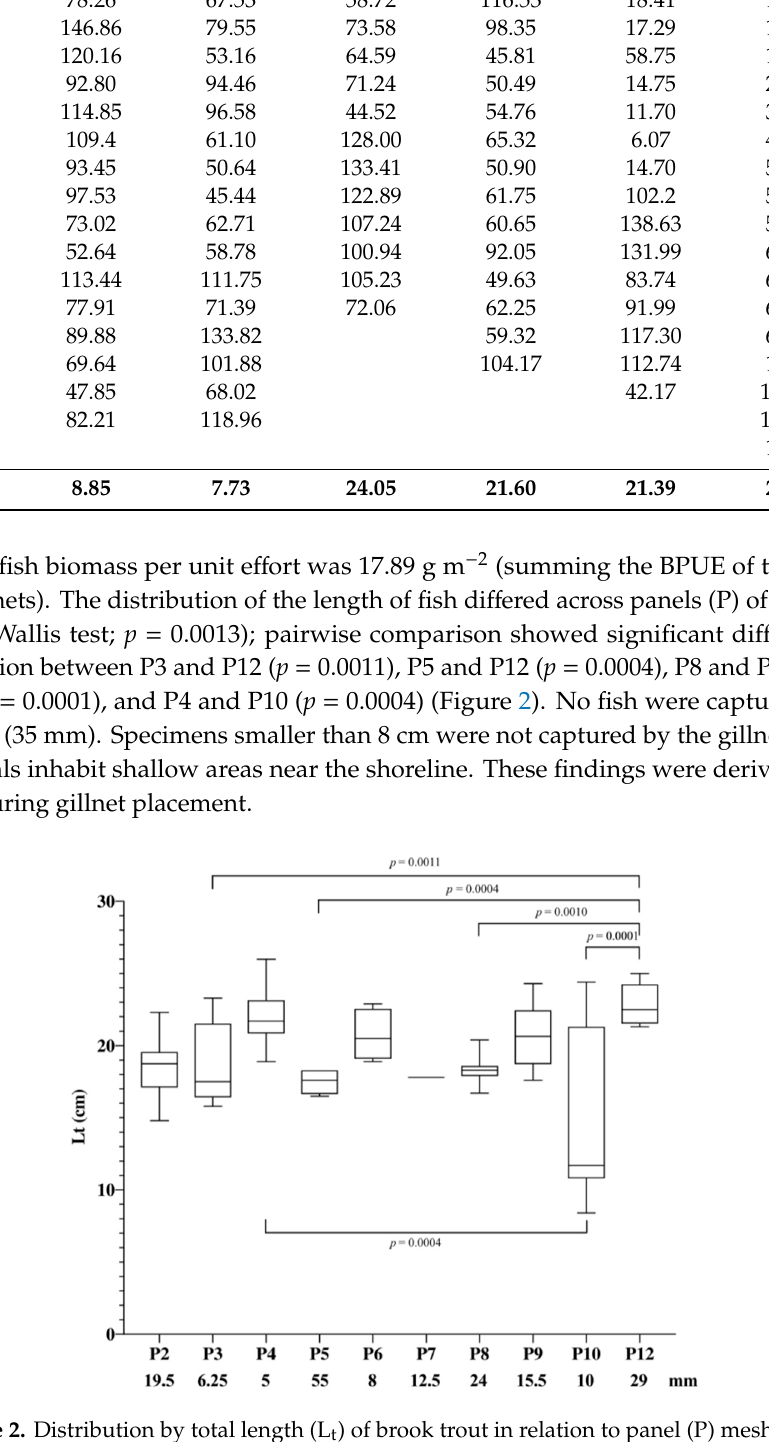
Table 3. Number of fish (n) captured with pelagic (A) and benthic (B) gillnets; the catch per unit effort-CPUE (no. of fish per m 2 per 12 h), the weight (W; g) of each fish; and the biomass per unit effort-BPUE (weight of fish per m 2 per 12 h). Gillnet